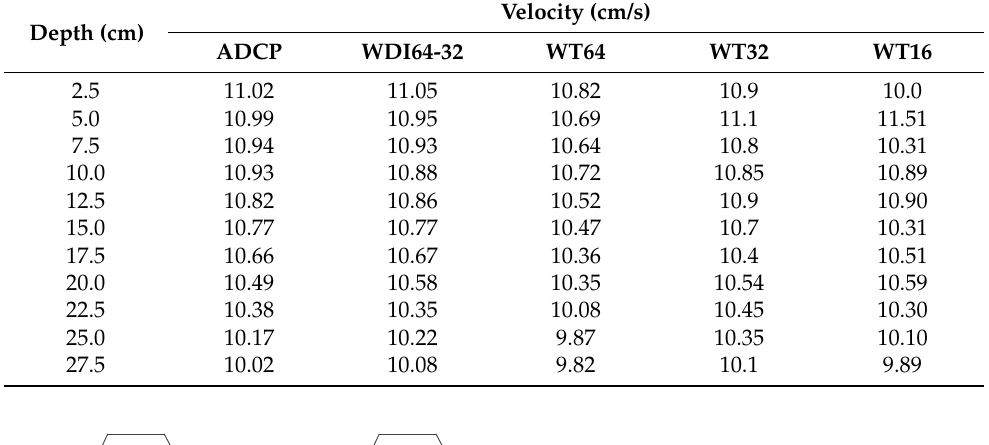
Figure 8. Two consecutive frames of ultrasonic images at at t ( b ) The ultrasound image t + ∆t